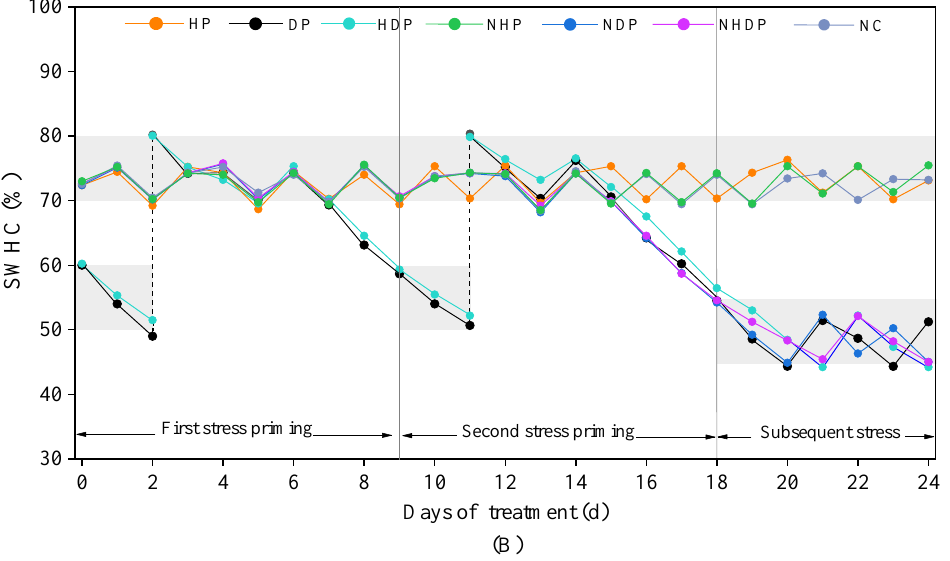
Figure 1. ( A ) Detailed representation of experimental design and treatments. HP, heat priming + later heat stress; DP, drought priming + later heat stress; HDP, combined stress priming + later combined stress; NHP, no heat priming + no later heat stress; NDP, no drought priming + no later drought stress; NHDP, no combined stress priming + no later combined stress; NC, no priming + no later stress. ( B ) Changes in the soil water content.